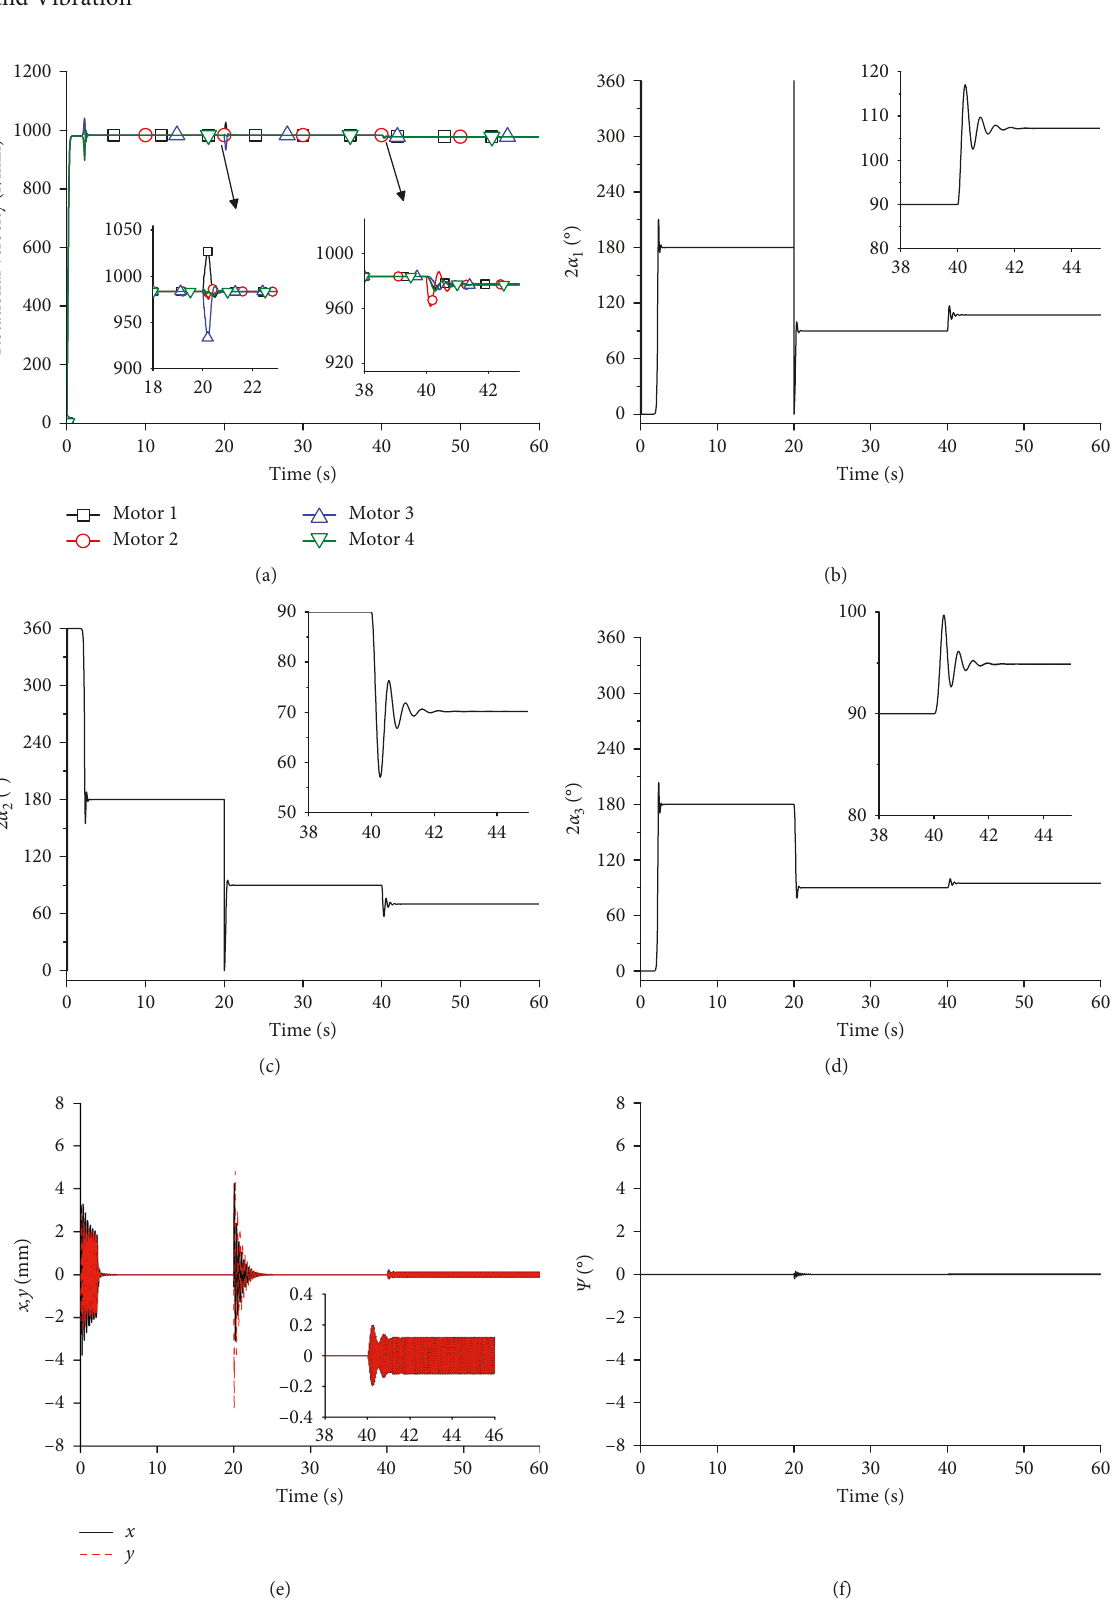
Figure 5: Results of computer simulations for η 1 (cid:31) η 2 (cid:31) η 3 (cid:31) η 4 (cid:31) 1. (a) Rotational velocities of the four motors; (b) phase difference between vibrator 1 and 2; (c) phase difference between vibrator 2 and 3; (d) phase difference between vibrator 3 and 4; (e) displacements in x and y directions; (f) displacement in ψ